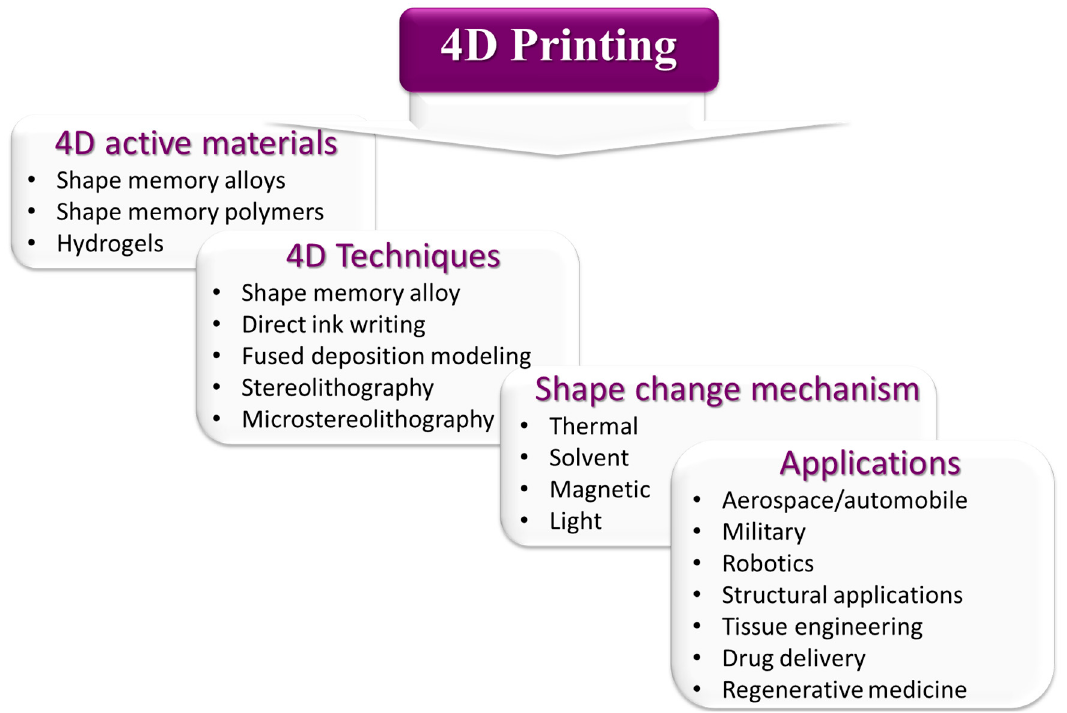
Figure 10. Aspects of 4D printing techniques.